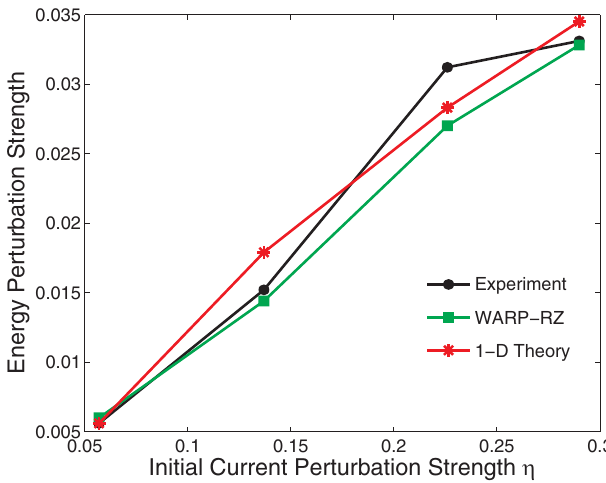
FIG. 7. (Color) The relationship between the strength of the energy perturbation and the initial strength of the current per- turbation.